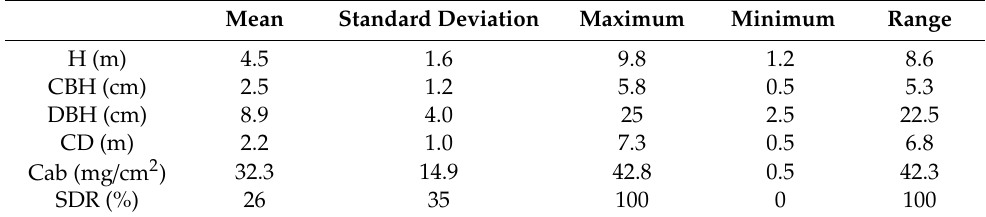
Table 1. Statistics of two plots variables (tree numbers = 448). H: Tree height; CBH: Crown base height; DBH: Diameter at breast height; CD: Crown diameter; Cab: Leaf chlorophyll content; SDR: Shoot damage ratio. Mean Standard Deviation Maximum Minimum Range H